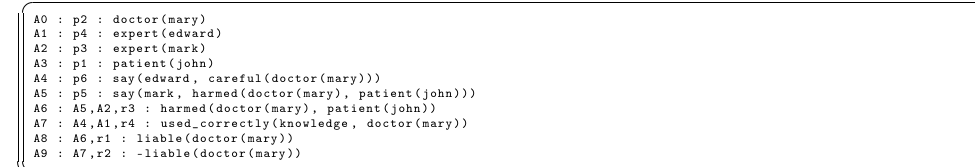
Figure 5. ASPIC+ formalism.